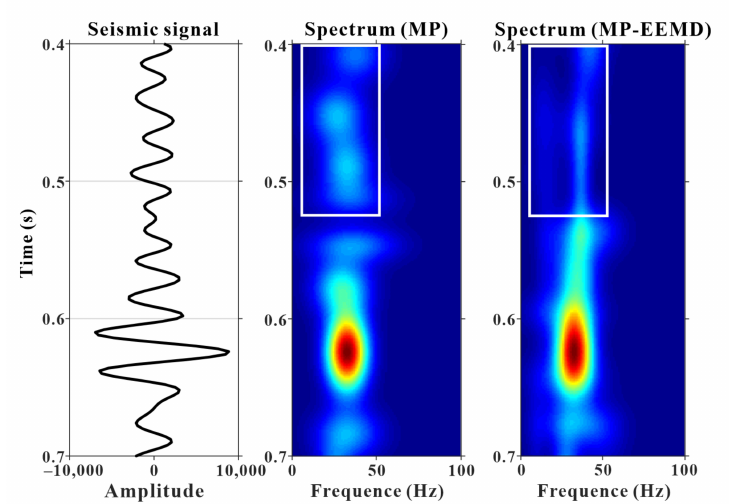
Figure 5. Real seismic signal ( left ), TF spectrum obtained by MP algorithm ( middle ), and TF spec- trum obtained by MP-EEMD algorithm ( right ). The cool colors represent small spectral amplitudes, and the warm colors represent large spectral